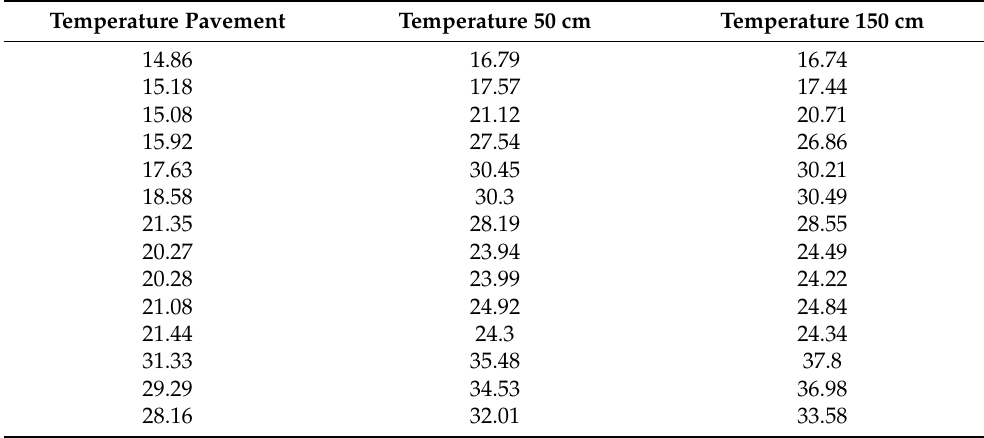
Table 2. Temperature of asphalt, 50 cm of height sensor and 150 cm of height throughout